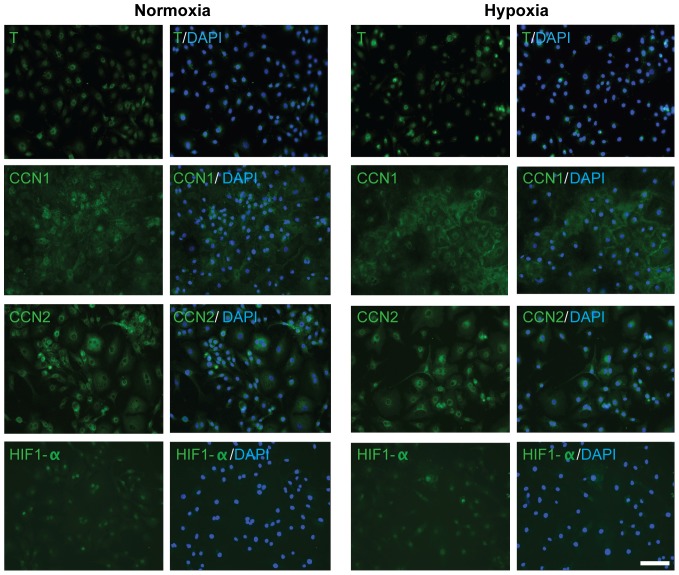
Expression and localization of T, CCN1, CCN2 and HIF-1α in U-CH1 cells maintained under normoxic (20% O2) or hypoxic (2% O2) conditions.Representative images demonstrating changes in the localization of target proteins in U-CH1 cells cultured in hypoxia. CCN1 demonstrates diffuse nuclear and cytoplasmic localization under normoxia but is concentrated to the cytoplasmic and cell periphery in cells under hypoxia. HIF-1α demonstrates primarily nuclear localization. CCN2 is localized to the nuclear and cytoplasmic region, and T is localized to the nuclear region under both normoxia and hypoxia. (n = 3; N = 3; scale bar  = 100 µm).